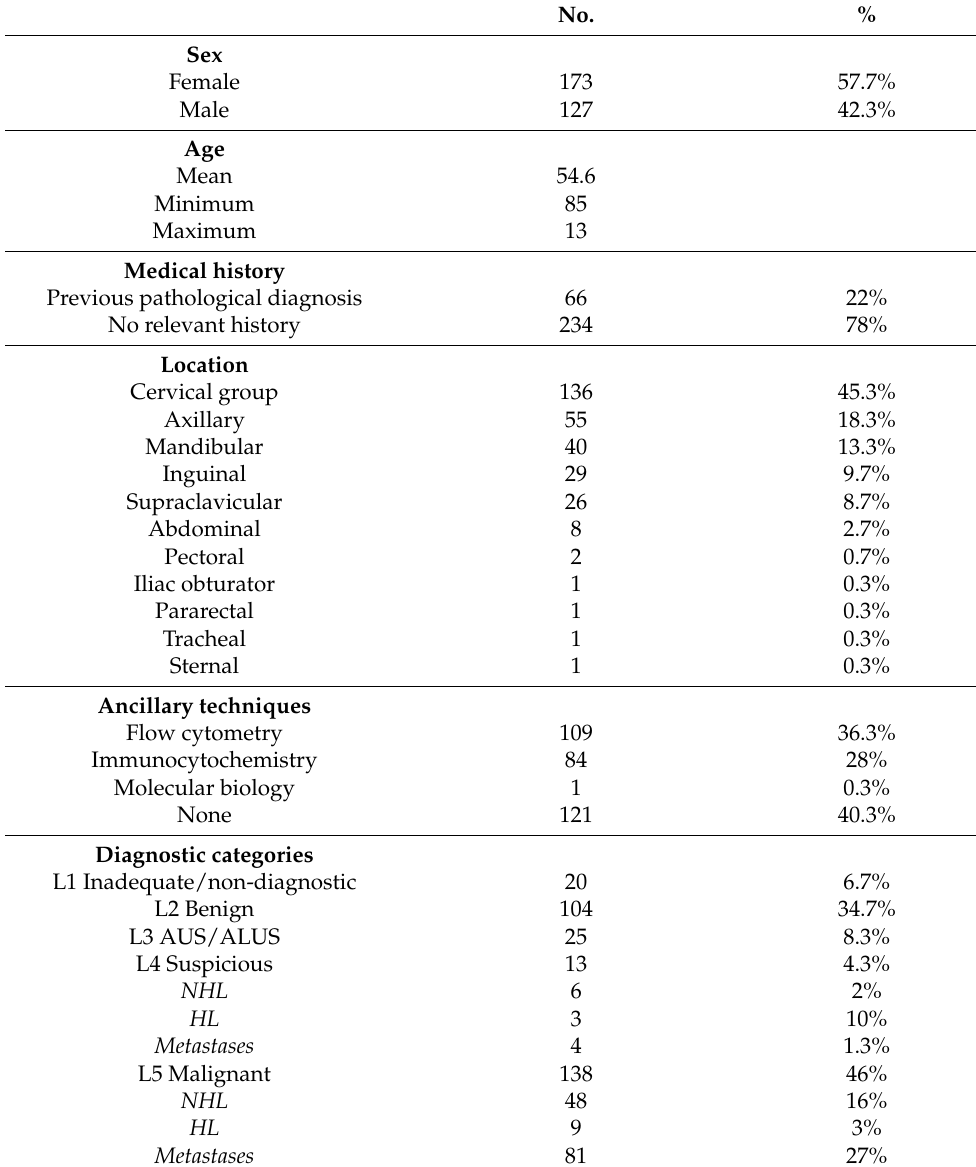
Table 1. Sample characteristics, clinical data, and diagnostic categories of 300 lymph node